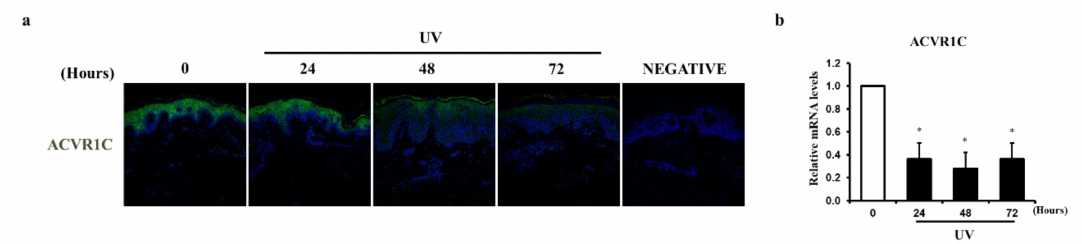
Figure 1. UV irradiation decreases activin A receptor type 1C (ACVR1C) expression in the human skin epidermis in vivo. Sun-protected buttock skin was irradiated with UV (two minimal erythema doses) and biopsied at the indicated times after UV irradiation. ( a ) ACVR1C protein levels were visualized by immunofluorescence staining (representative images, n = 3); ( b ) the epidermis was separated from the whole skin sample. ACVR1C mRNA levels were examined by quantitative RT-PCR (n = 4). Data are presented as means ± standard error of mean (SEM) of the expression of ACVR1C gene relative to 36B4. * p < 0.05 versus the non-irradiated